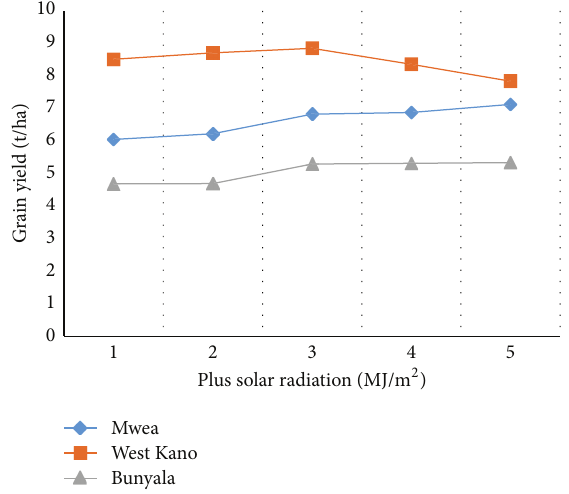
Figure 6: Effects of plus solar radiation on Basmati 370 grain yield in Mwea and IR 2793-80-1 grain yield in West Kano and Bunyala under SRI.